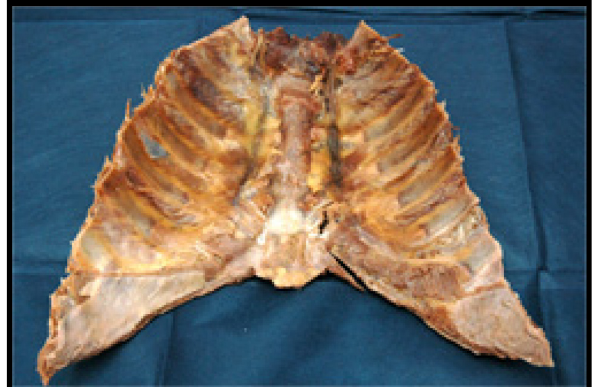
node dissection